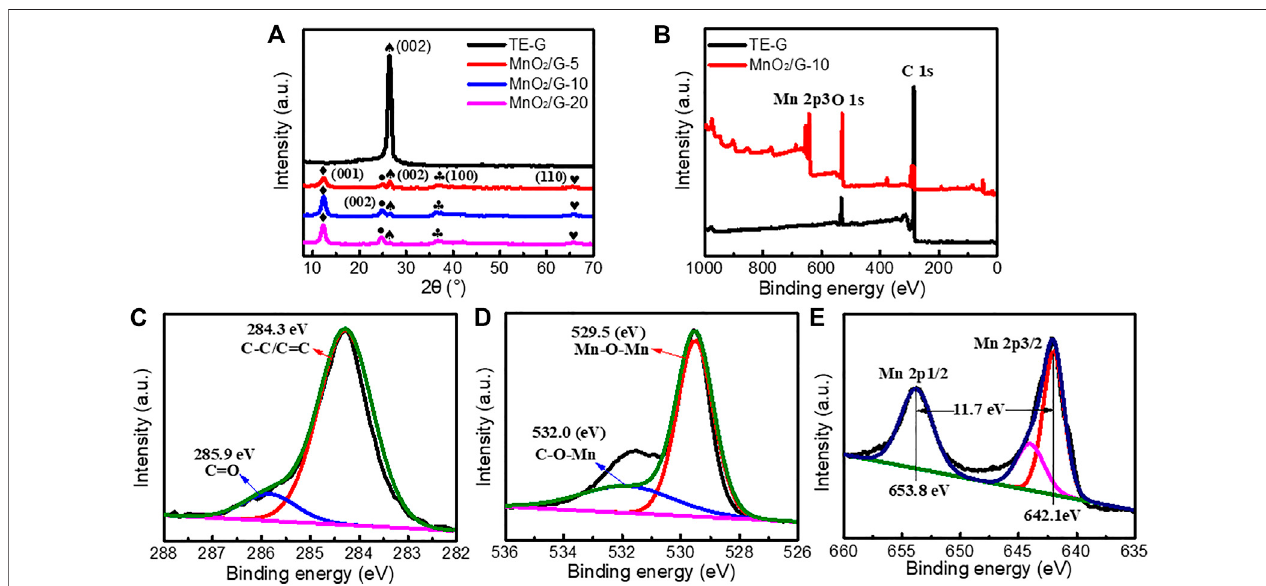
FIGURE 5 | The XRD patterns (A) and XPS survey spectra (B) of pure TE-G and MnO 2 /G-10 sample, and the magni fi ed C (C) , O (D) , and Mn (E) XPS spectrum.